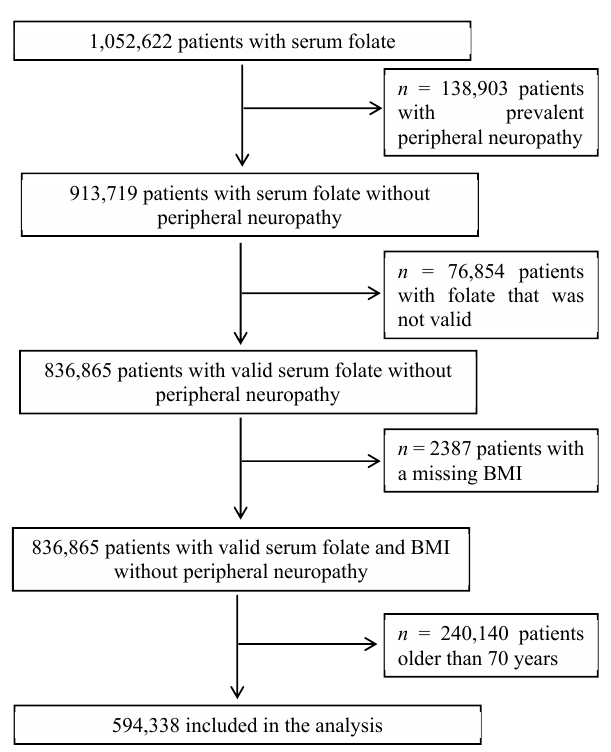
Figure 1. Flow diagram of patients included for an association between serum concentrations of folate and the risk of peripheral neuropathy and